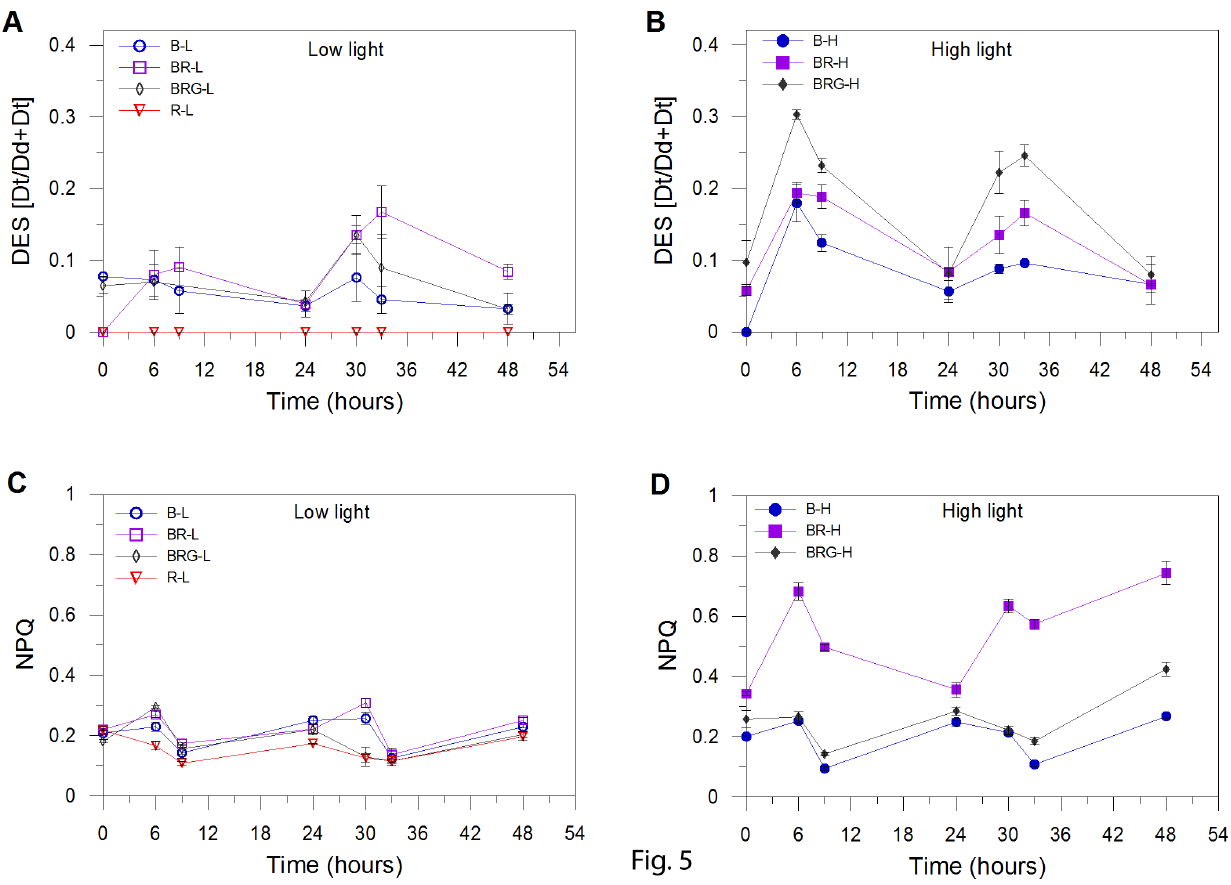
Figure 5. De-epoxidation state (DES=Dt/(Dd + Dt)) and non-photochemical quenching (NPQ). Time distribution of DES in (A) low and (B) high light. Time distribution of NPQ in low (C) and high light (D). B-L, BR-L, BRG-L, R-L are blue, blue-red, blue-red-green, and red low light conditions, respectively; B-H, BR-H, and BRG-H are blue, blue-red, blue-red-green high light conditions, respectively. Time is in hours after the start of the experiment. Data represent mean 6 SD ( n =3).